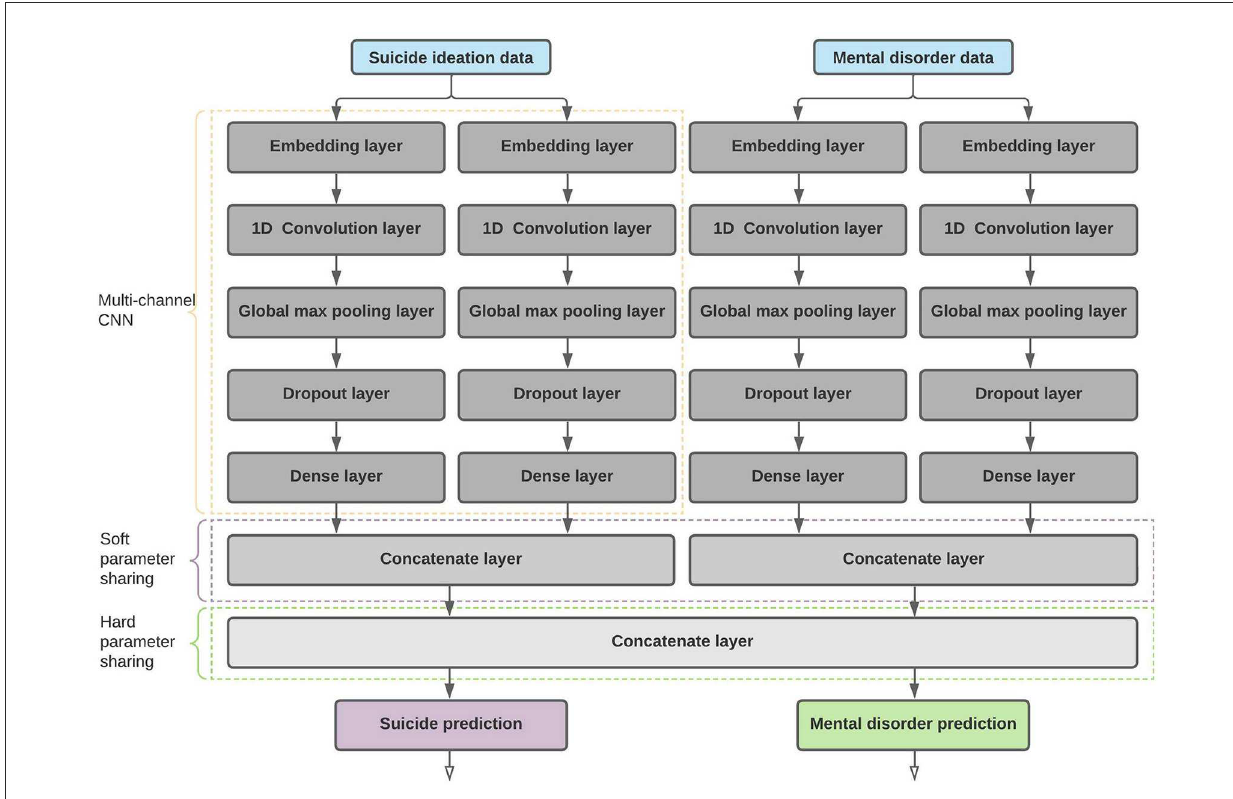
FIGURE3 Proposed MTL architecture with soft and hard parameter